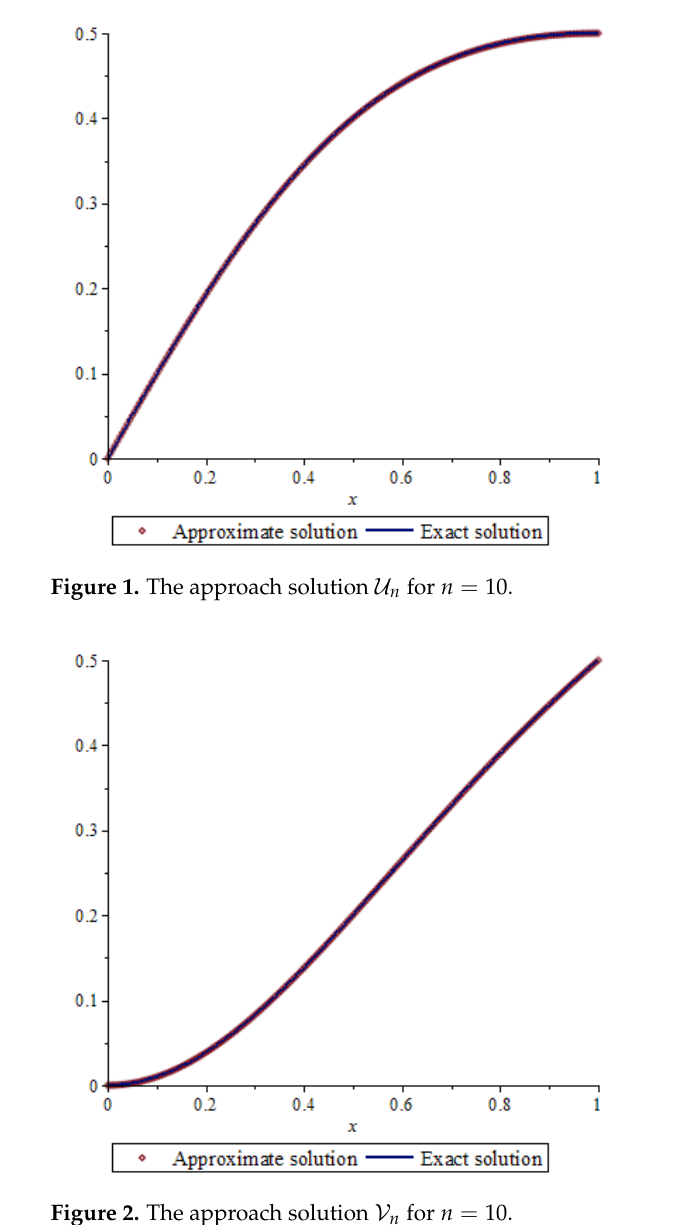
Figure 2. The approach solution V n for n =